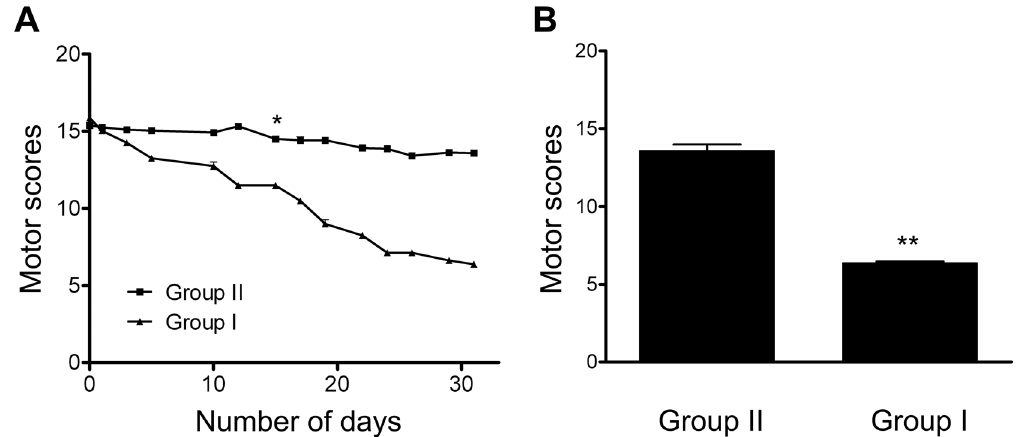
Figure 3. Chronic effects of L-Dopa treatments on total motor scores. (A) Evolution of daily motor scores during L-Dopa treatment. Timelines are aligned such that day 0 corresponds to the day on which the MPTP intoxication was stopped for each animal. Monkeys in group I received L-Dopa from day 1 and scores were taken from recordings prior to the daily L-Dopa administration. Significant differences between the two groups appeared at day 15 and continued into the later days (day 16–30). (B) Total Kurlan scores on day 31 of the two groups. Monkeys in group I received L-Dopa and displayed improvement in their total PD scores compared with the control group. Group I, n=2; group II, n=3. * P , 0.05, ** P , 0.001. Data are presented as mean 6 SEM.